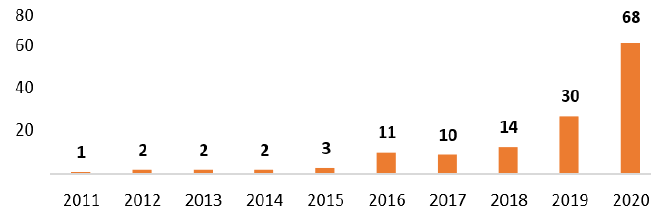
Figure 2. Evolution of the Number of Publications per Year.